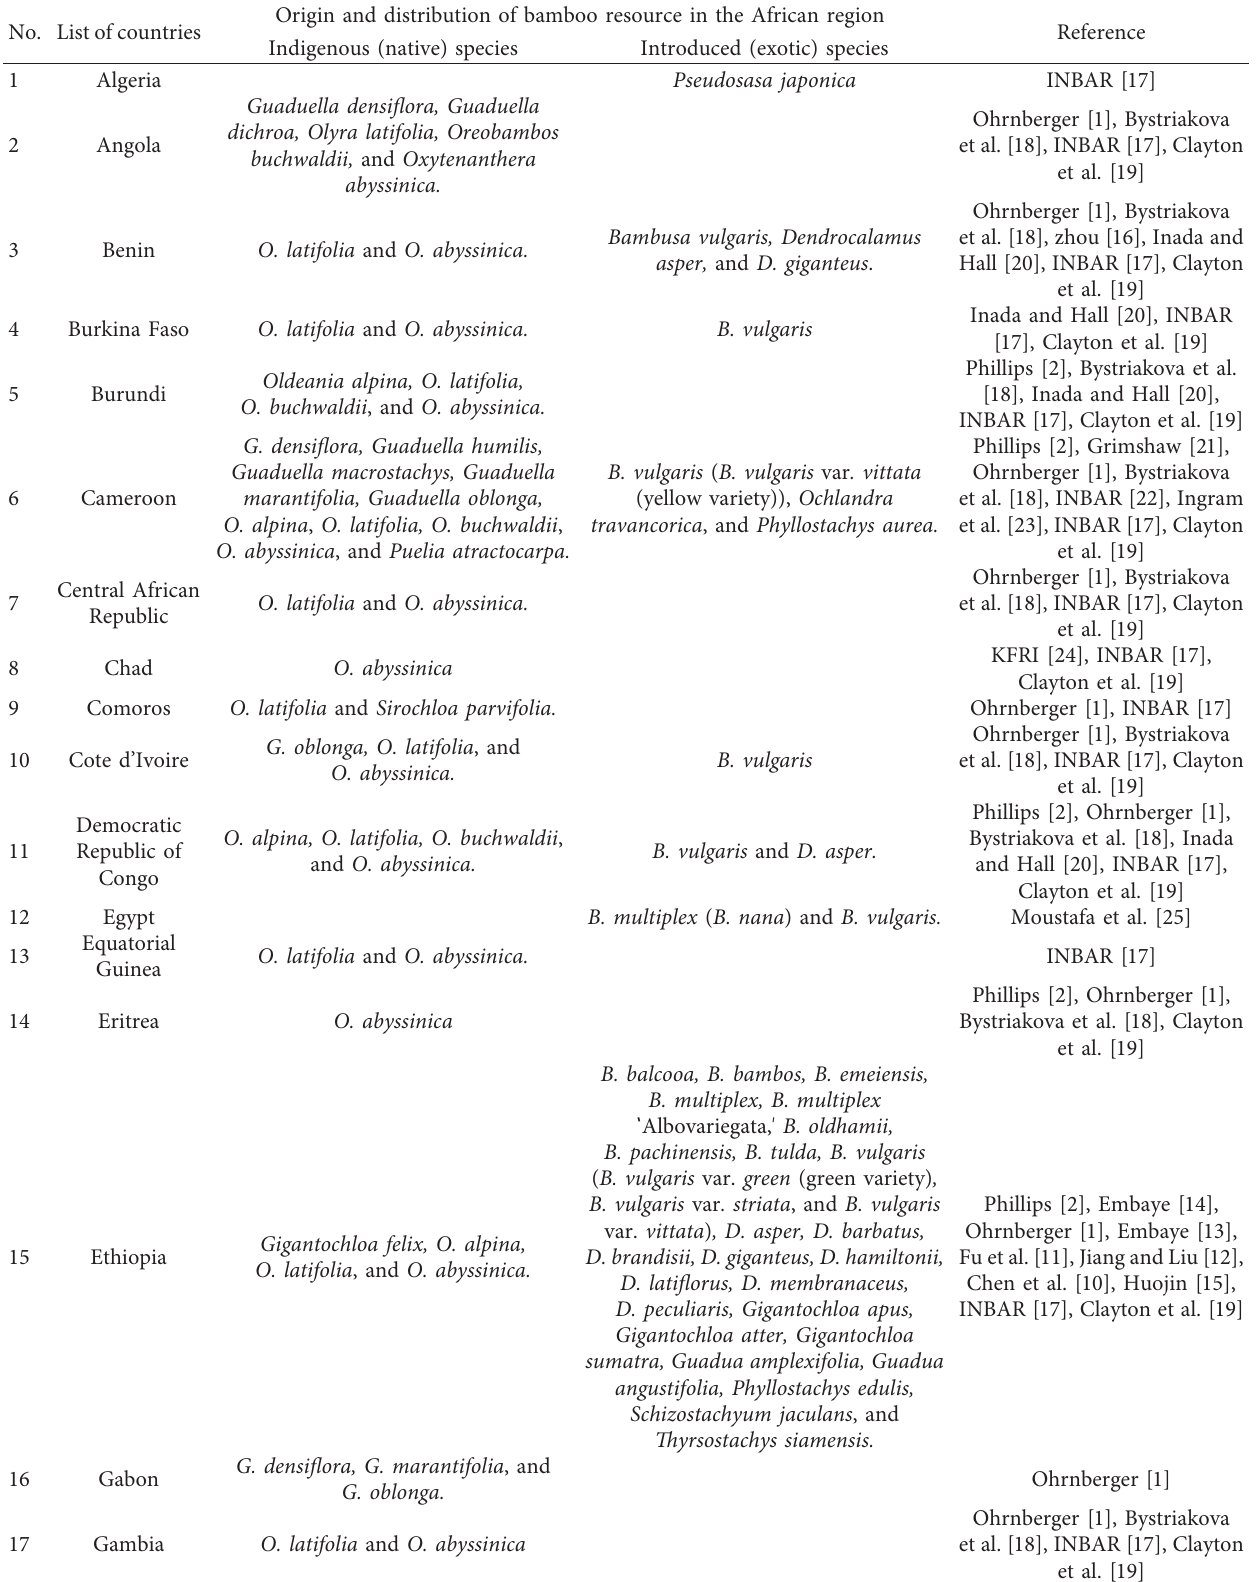
Table 1: Origin and distribution of bamboo resource in the African